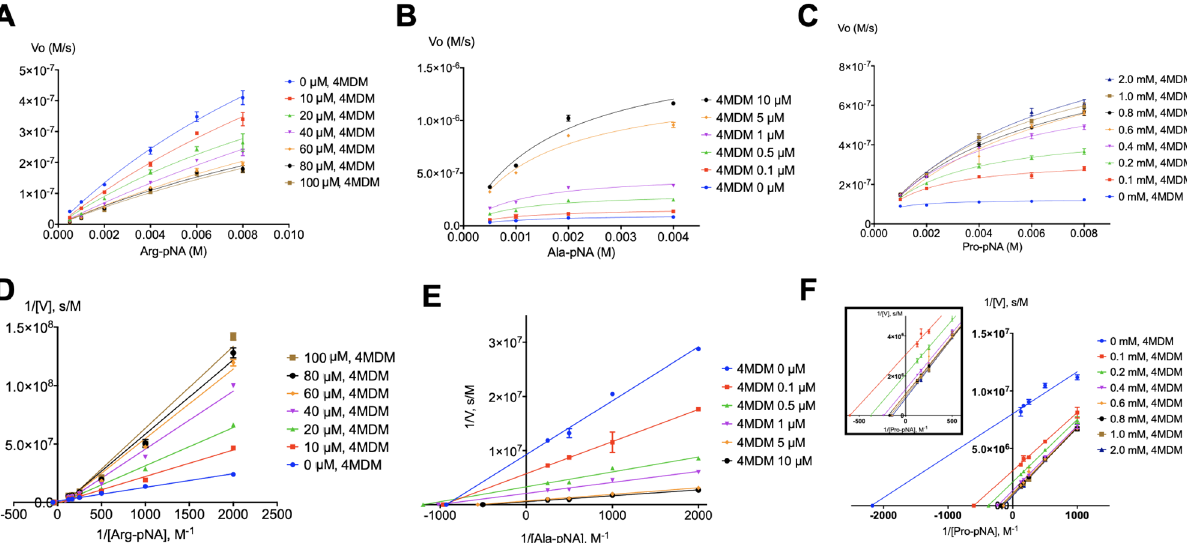
Figure 6. Enzyme kinetic data represented in the Michaelis–Menten plot ( A , B , C ) and Lineweaver–Burk plot ( D , E , F ). In the presence of 4MDM, the hyperbolic mixed predominantly specific inhibition is shown with Arg- p NA ( A , D ), the hyperbolic mixed predominantly catalytic activation with Ala- p NA ( B , E ), and the hyperbolic catalytic activation with Pro- p NA ( C , F ). The bars represent ± standard deviation from six replicates (n =